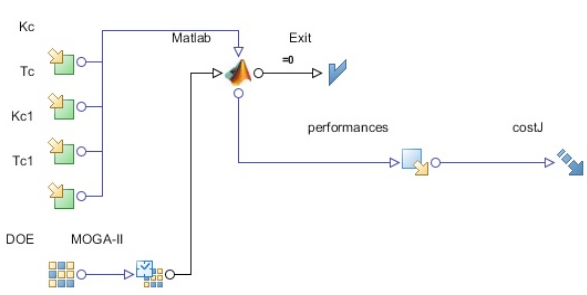
Fig. 8. Optimization scheme in mode FRONTIER